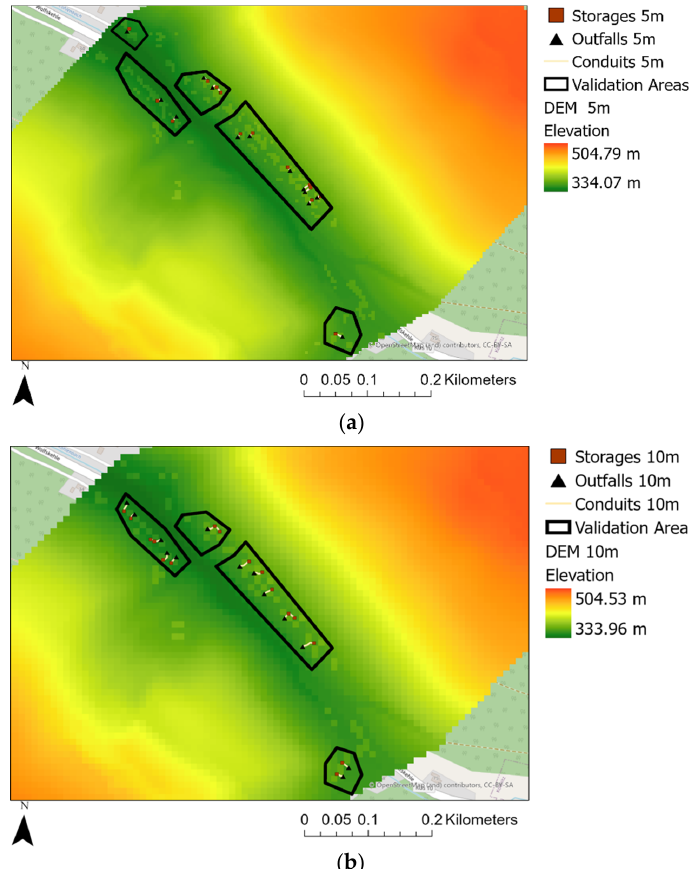
Figure 3. Subdivision into subzones, as follows: ( a ) subzones for the 5 m model; ( b ) subzones for the 10 m model.